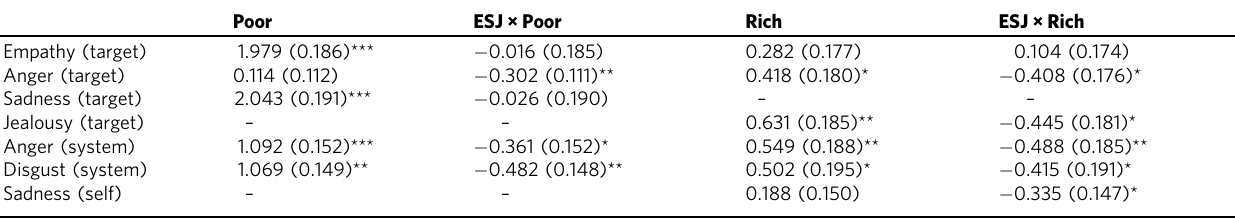
Table 8 Daily emotions as a function of ESJ and encounters with rich and poor people in Study